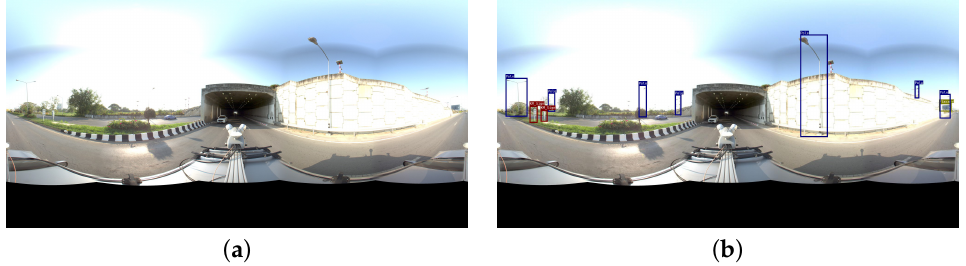
Figure 1. The challenges in the Road Asset corpus. Sample of input image ( a ) and target image ( b